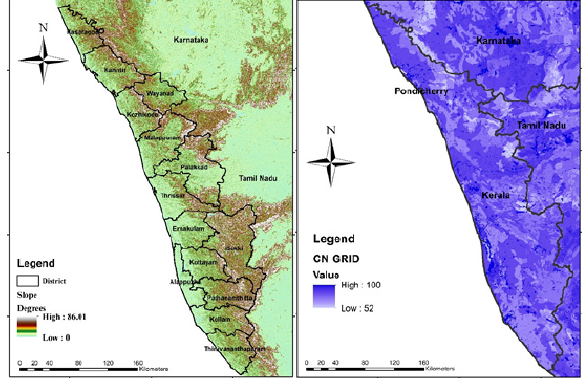
Figure 4. a) Slope, and b) Curve Number Grid map of Kerala